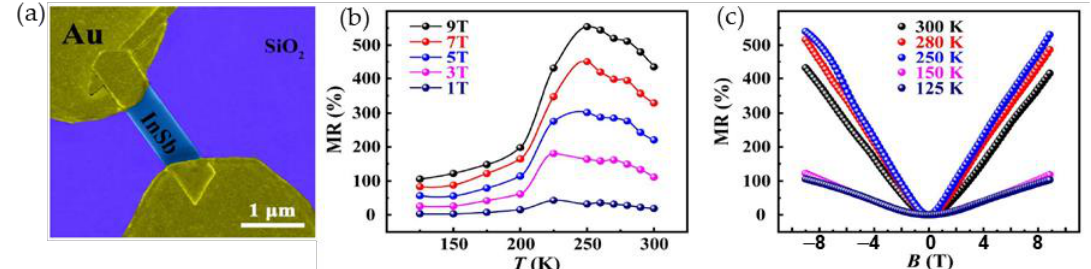
Figure 16. ( a ) SEM image (false-colored) of two-terminal InSb nanosheet; ( b ) temperature depend- ence of MR different magnetic fields; and ( c ) the MR dependences on magnetic field at different temperatures. Reprinted with permission from [105]. Copyright 2020 IOP Publishing.